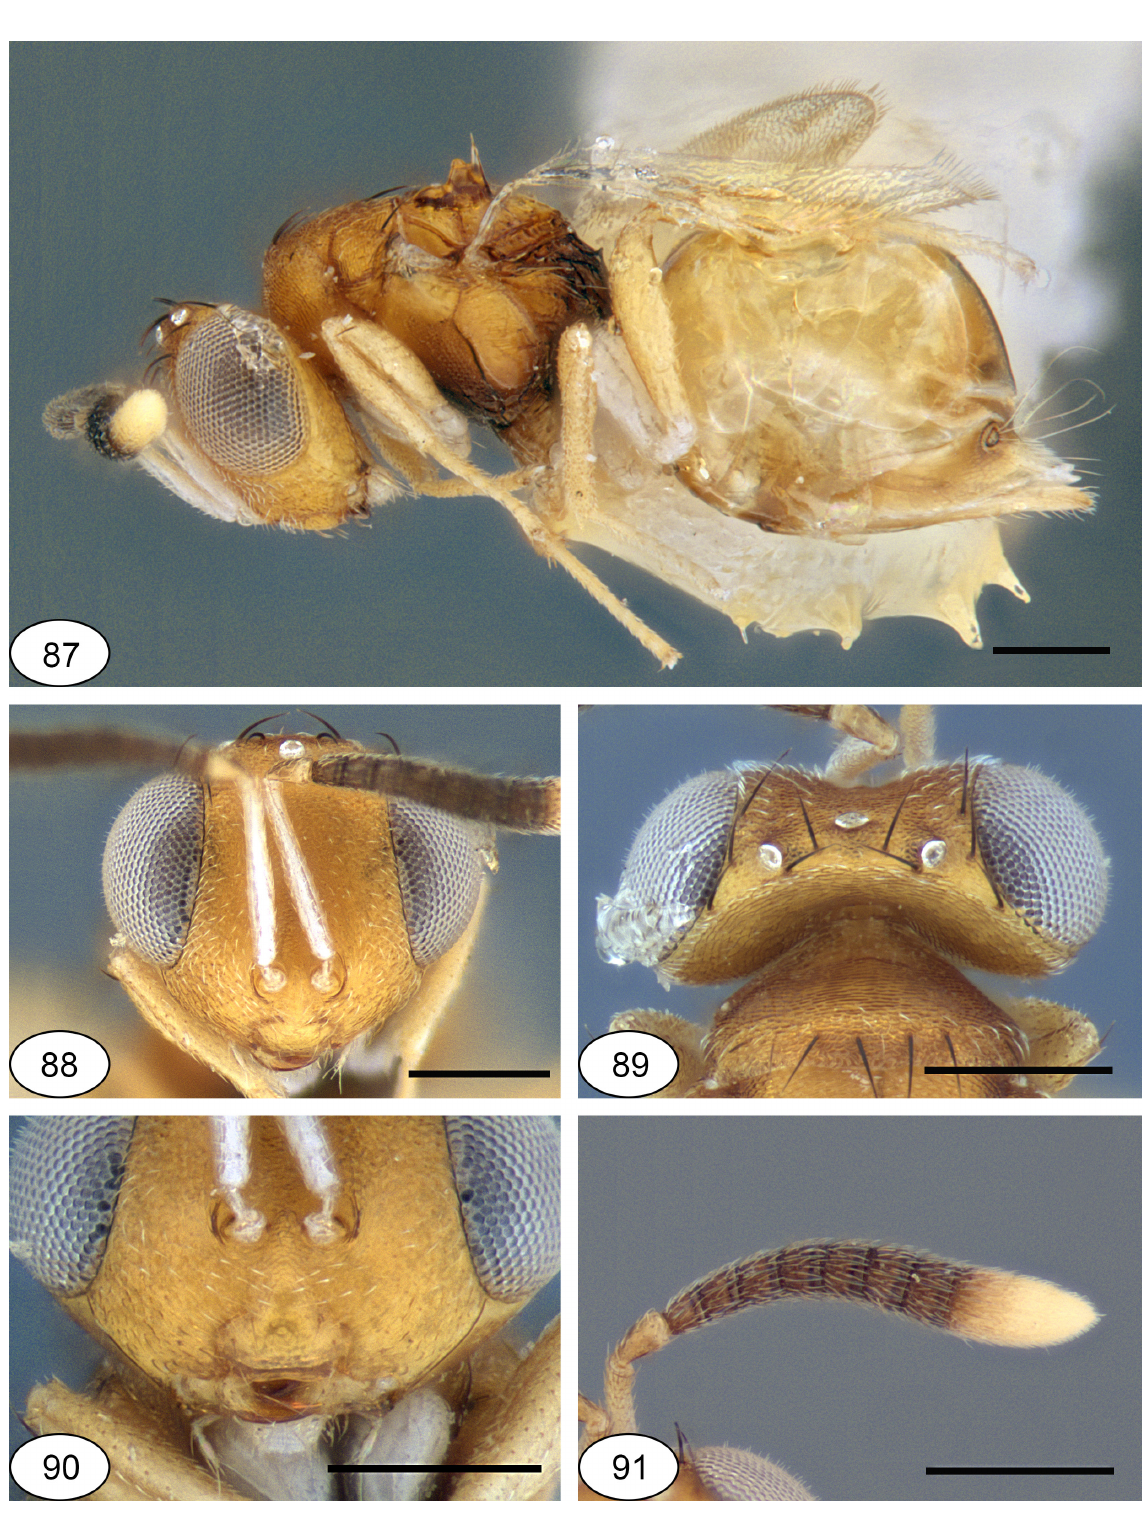
Figs 87–91. Netomocera irregularis sp. nov., holotype, ♀. 87 . Habitus, lateral view. 88 . Head, frontal view. 89 . Head, dorsal view. 90 . Lower face. 91 . Antenna. Scale bars: 0.2